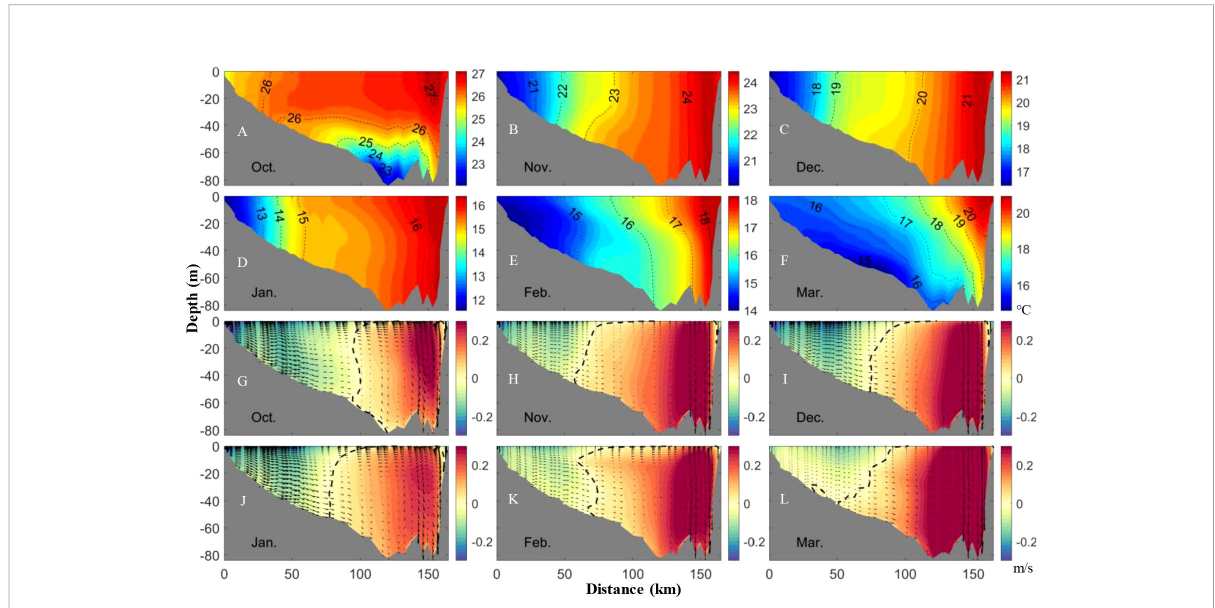
FIGURE 8 Vertical structure of temperature (A-F) and fl ow ( G-L , along-isobath component in colors, northward positive; cross-isobath and vertical components in arrows, vertical velocity is multiplied by 1000) along sec1 from October 2020 to March 2021. The dotted lines in subgraphs (G – L) indicate the location of 0 m/s of along-isobath